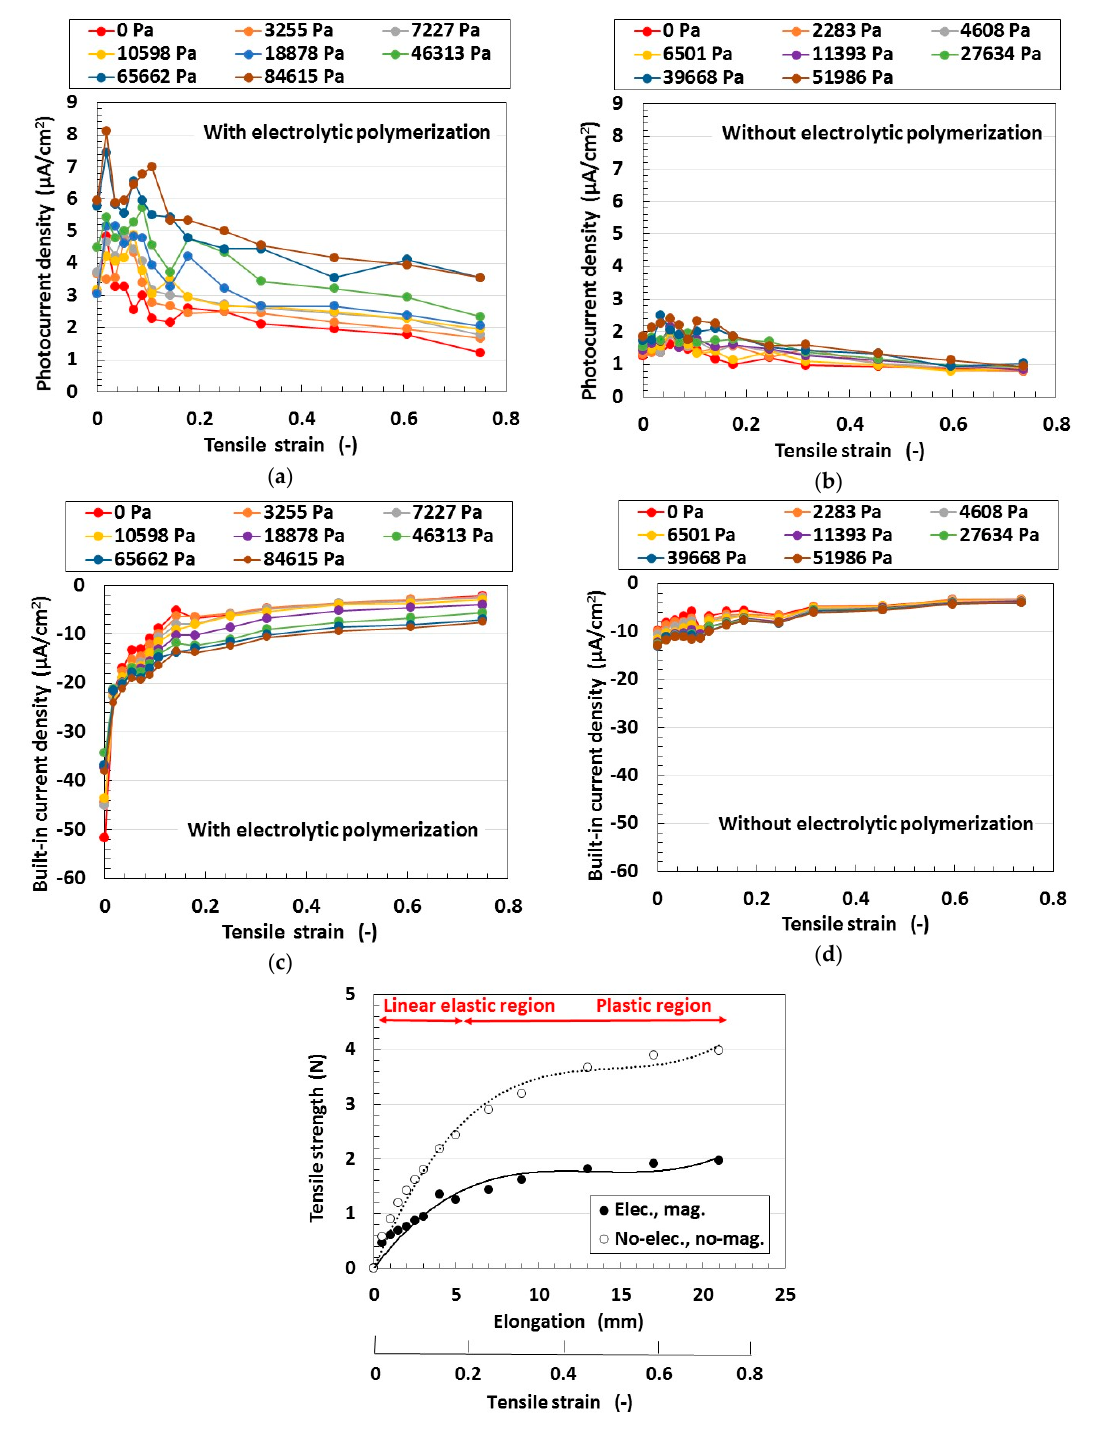
Figure 11. Changes in the electrolytic polymerization effect due to tension under irradiation with ultraviolet light: ( e ) represents the relation between the tensile strength and elongation; elongation rates in various cases ( a – d ) for wet-type MCF rubber solar cell electrolytically polymerized under a magnetic field with Ruthenium complexes dye and electrolyte KI + I 2 .